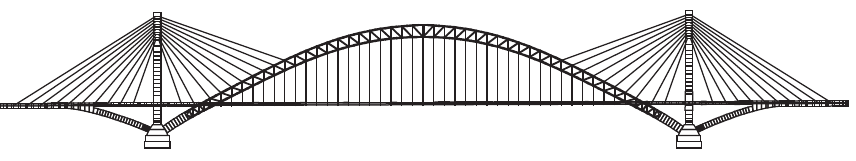
Figure 1: Lateral view of a cable-stayed shallow arch bridge.